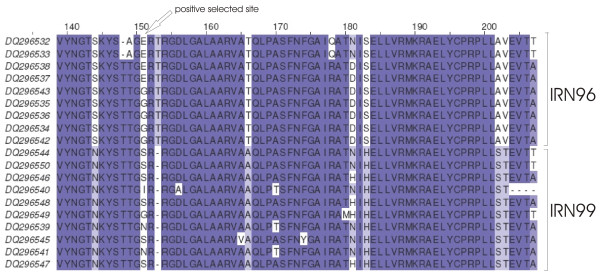
Amino Acid – alignment of the GH-loop (residues 140–160) from both serotype A lineages IRN99 and IRN96. Virus isolates are named after the Genbank Accession-number. Complete deletion at site 153 of the IRN99 lineage, as well as lineage specific conserved amino acids at the sites: 144, 166, 183, 202 and 203. The potential integrin binding site Arg-Gly-Asp (RGD) [8], is in all but DQ296541, as 'RGDLGAL'-motif present.